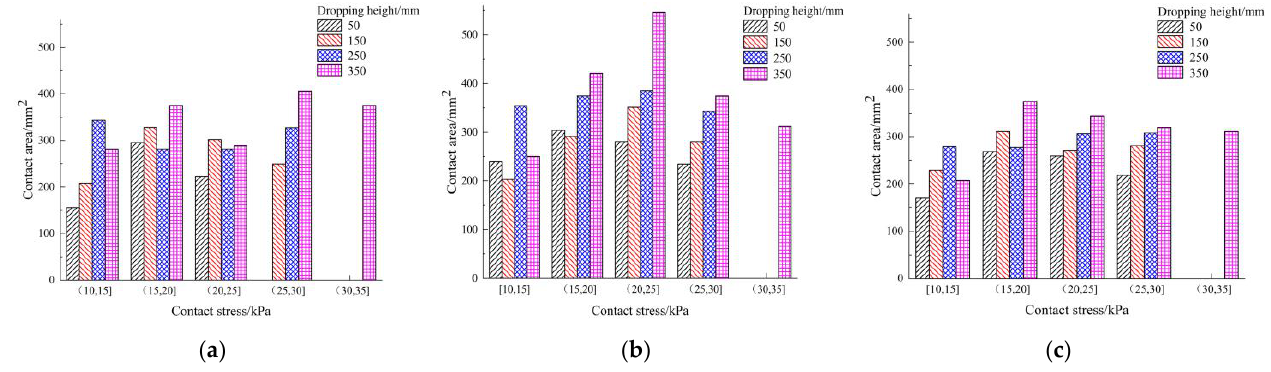
Figure 8. Contact stress distribution of oil sunflower seedlings of three contact materials under different drop heights. ( a ) Steel; ( b ) soil; ( c ) ABS plastic. The experiment was carried out in the Ag-